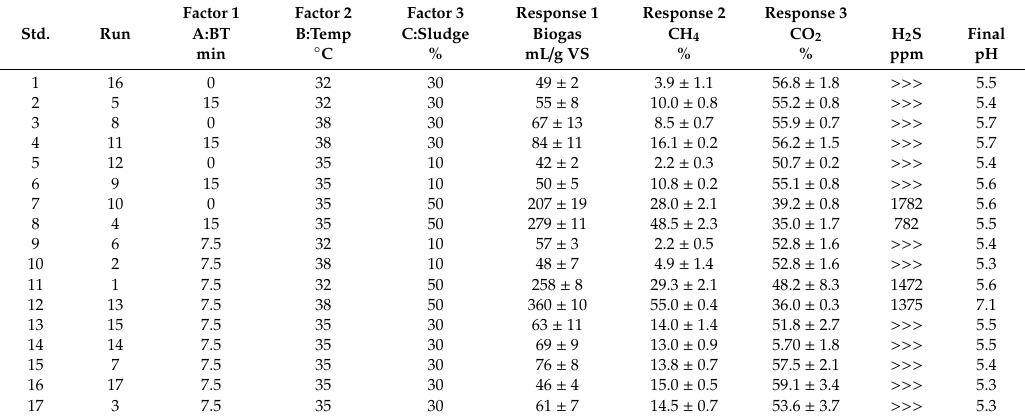
Table 8. Design matrix for anaerobic co-digestion of pot ale and spent grain (5:1, by weight).